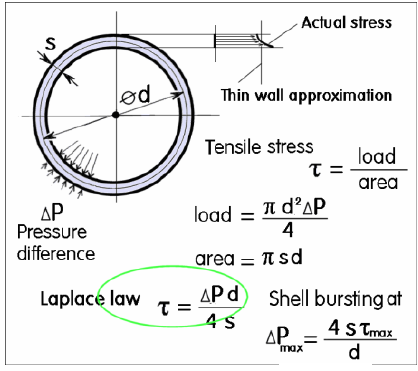
Fig. 13. Thermal expansion of the phase-change materials causes in the walls of closed-volume shell a tensile stress which may reach the strength limit of the shell material, which then bursts open.